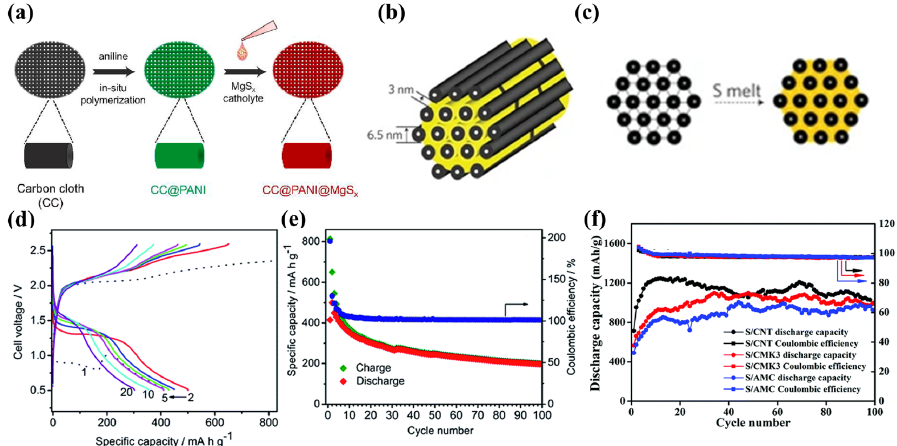
Figure 7. ( a ) Diagram of synthesis of CC@PANI@MgS x [36] . ( b ) CMK − 3 structure schematic. ( c ) Preparation schematic diagram of S/CMK − 3 [52] . ( d , e ) The S/CMK − 3 electrochemical performance in Mg [B(hfip) 4 ] 2 electrolyte. ( f ) S/AMC, S/CNT, and S/CMK − 3 cycling performance in 0.5 M OMBB